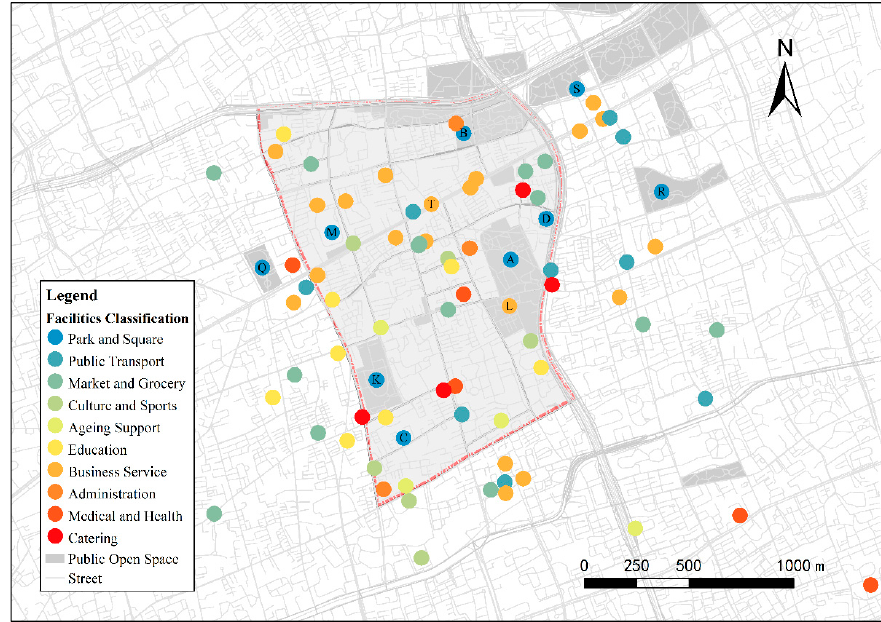
Figure 4. Map of public spaces marked by residents; nodes accompanied by letters are POSs.